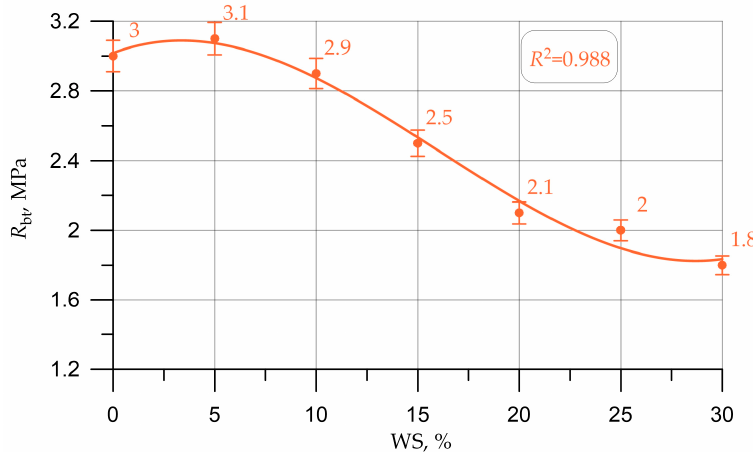
Figure 9. Dependence of the axial TS of concrete on the amount of walnut shell.